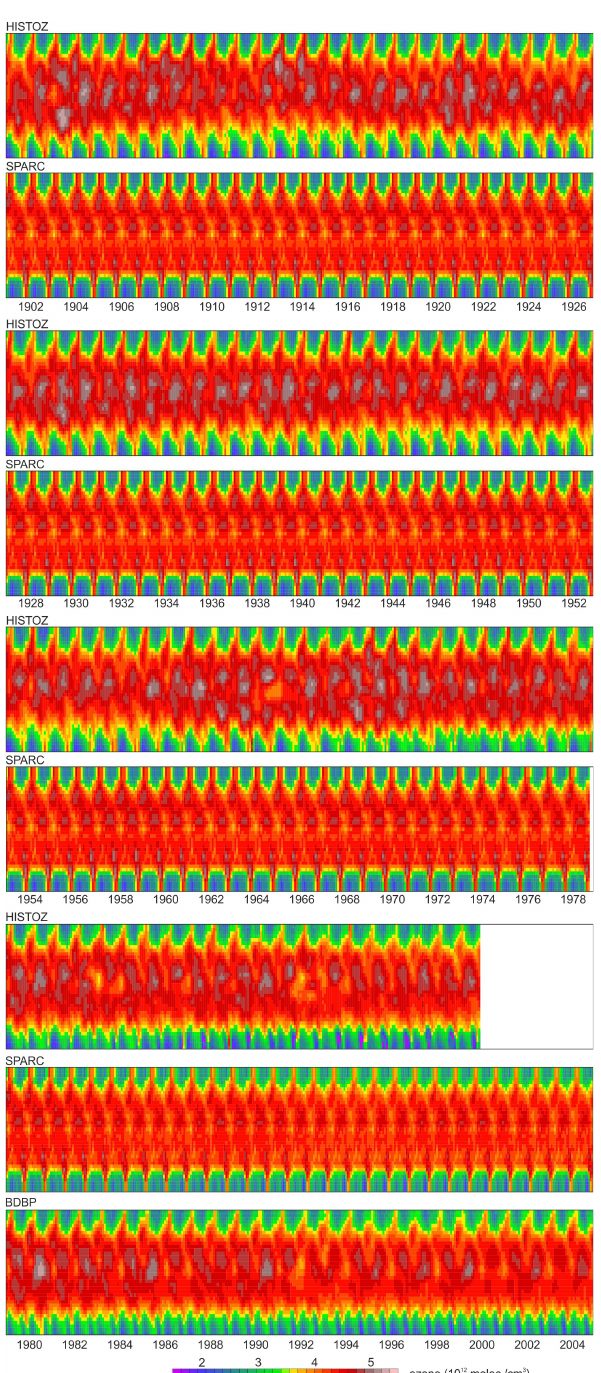
Fig. 5. Latitude-time cross section of HISTOZ.1.0, the SPARC data set, and BDBP (after 1979 only) at 25.1hPa from 1901 to 2004.